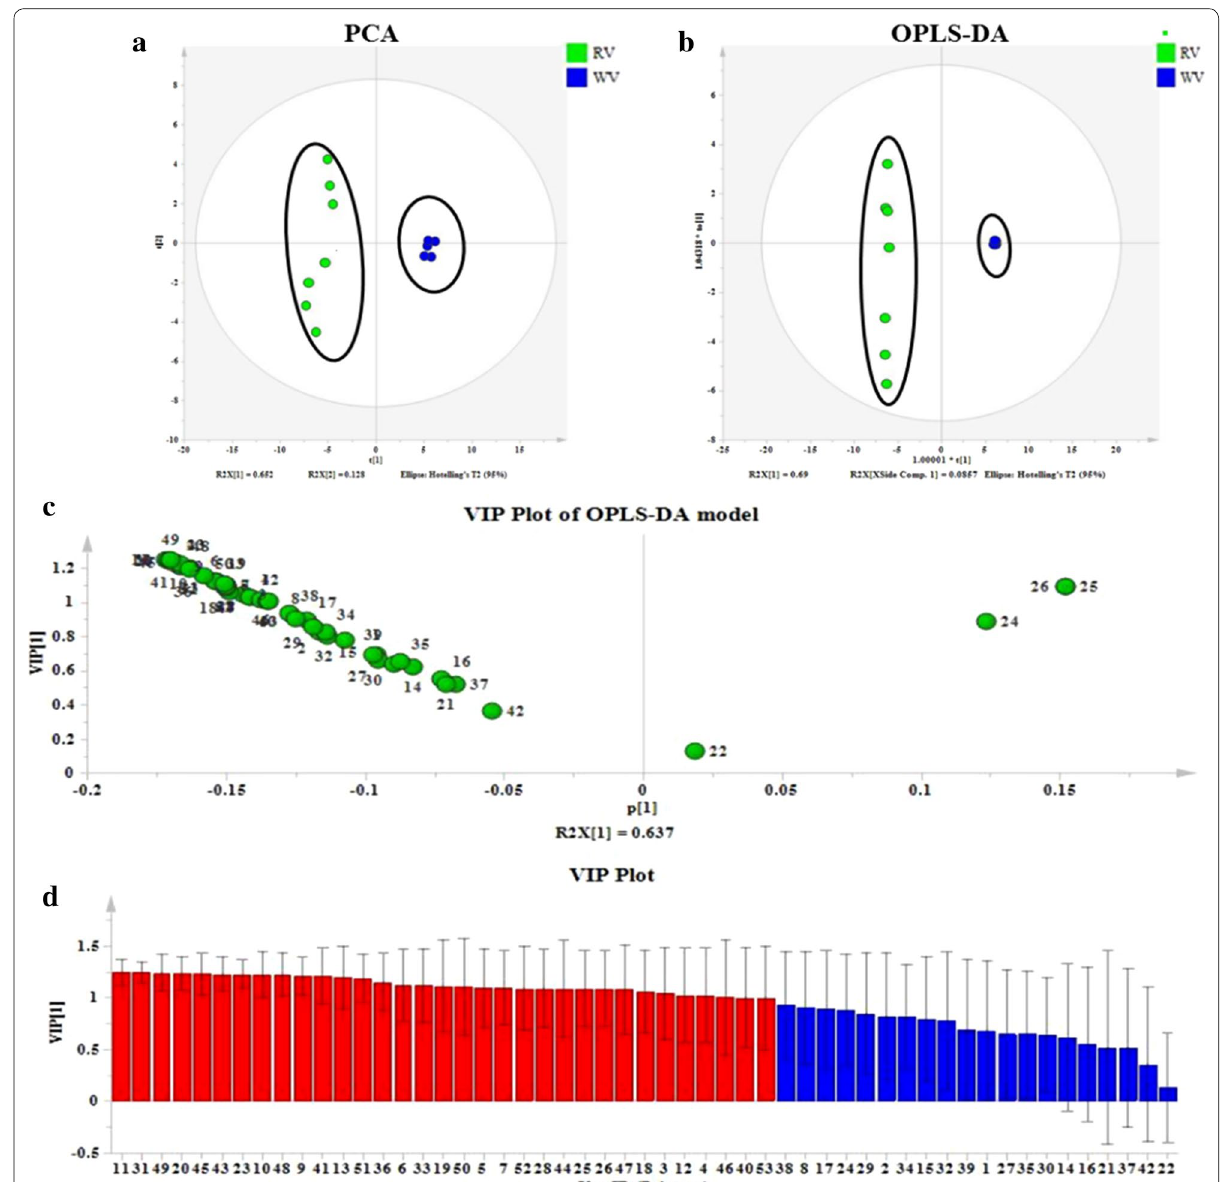
Fig. 2 Multivariate statistical analysis of RV and WV. a PCA score plots of two different kinds of vinegar; b OPLS-DA of two different kinds of vinegar; c variable important (VIP) plot of OPLA-DA model between two different kinds of vinegar; d VIP plot of two different kinds of